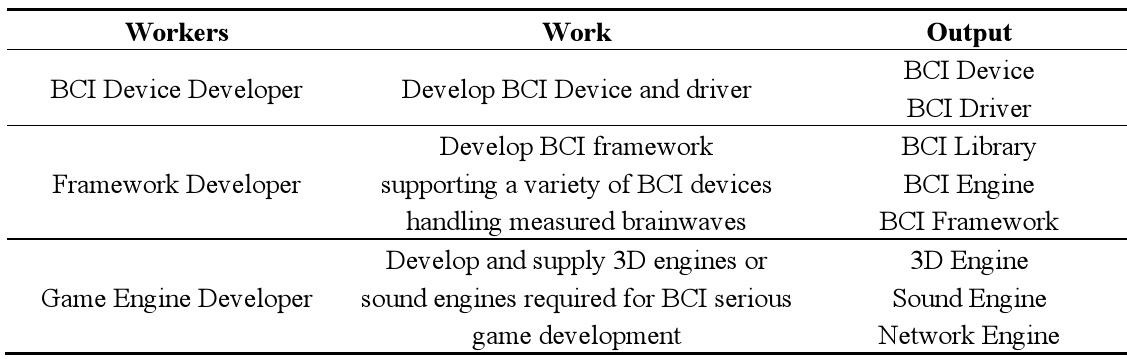
Table 2. Output from third